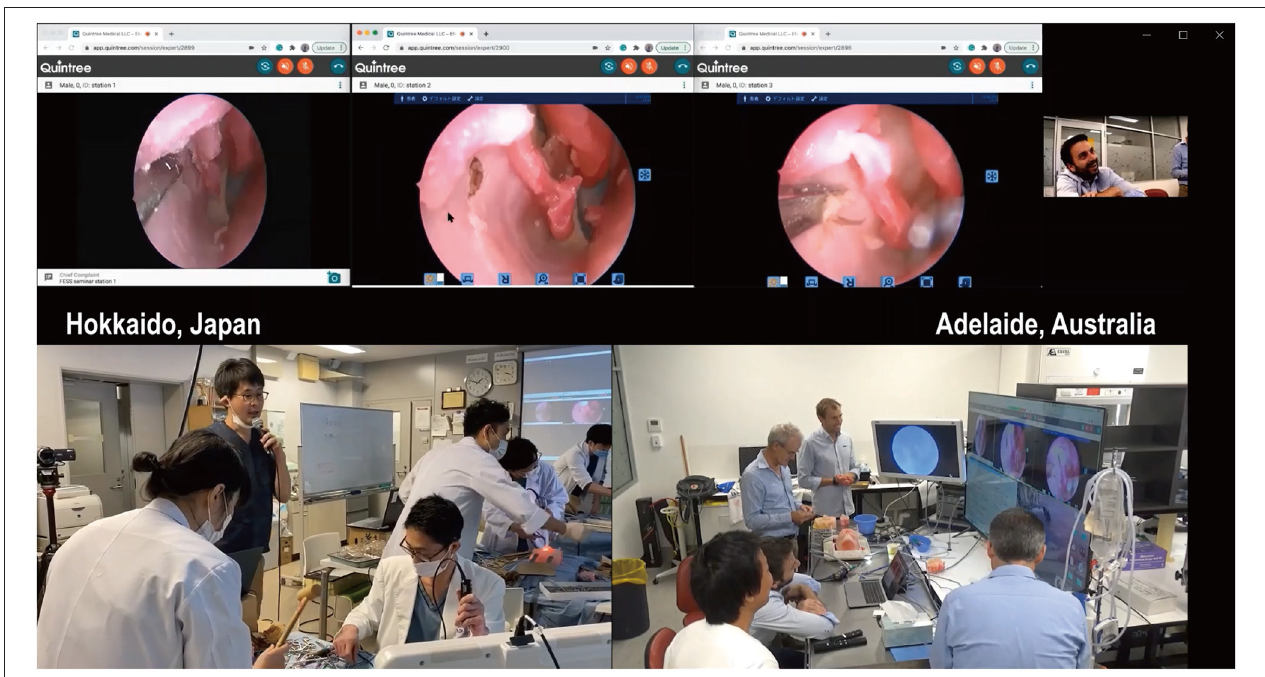
FIGURE 1 | The remote endoscopic surgery training course was conducted between Hokkaido, Japan, and Adelaide, Australia, and broadcasted worldwide. The course was held over 2 days in February 2021. Three otolaryngologists in Hokkaido were trained to perform frontal sinus dissections on 3D sinus models printed from CT scans of patients. Two rhinologists based in Adelaide, 8,000-km away from Hokkaido, simultaneously viewed the surgeries and provided real-time feedback using a telemedicine platform, Quintree. The course was also broadcast worldwide to over 200 otolaryngologists’ personal